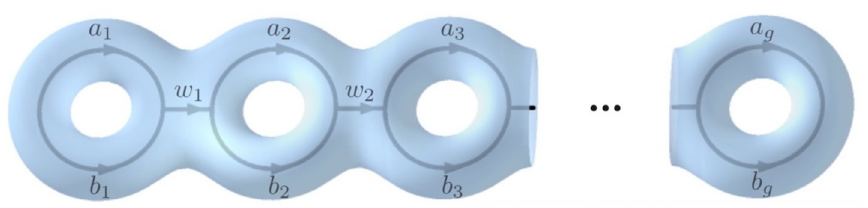
Figure 7 . a 1 ; 2 ;:::;g ; b 1 ; 2 ;:::;g ; w 1 ; 2 ;:::;g (cid:0) 1 2 f 1 ; (cid:27); g . Fusion rules need to be applied at each trivalent vertex for the fusion diagram to be